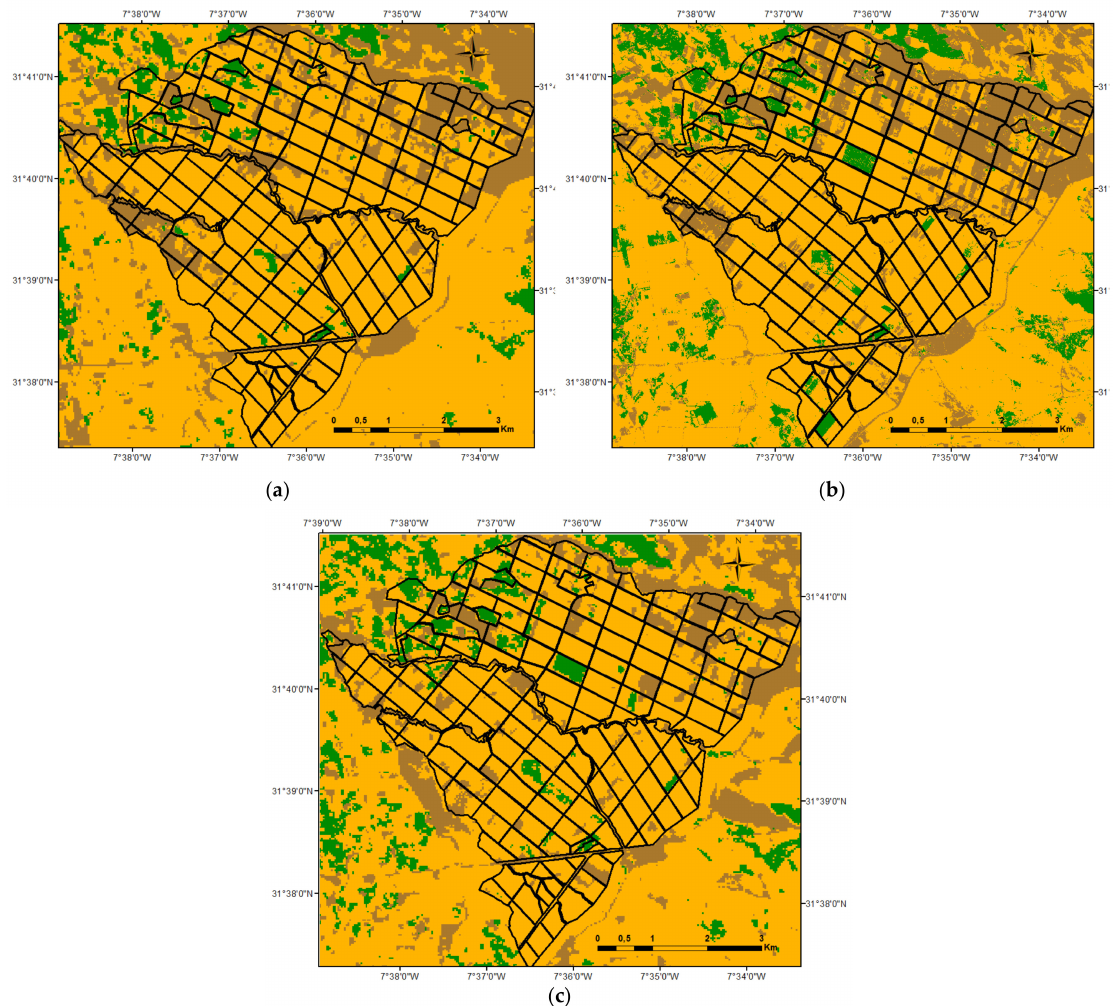
Figure 3. Land cover maps for the 2002–2003 ( a ), 2005–2006 ( b ) and 2008–2009 ( c ) seasons in the R3 irrigation district. The colors represent the trees (in green), the wheat crop (in yellow) and bare soil/fallow (in